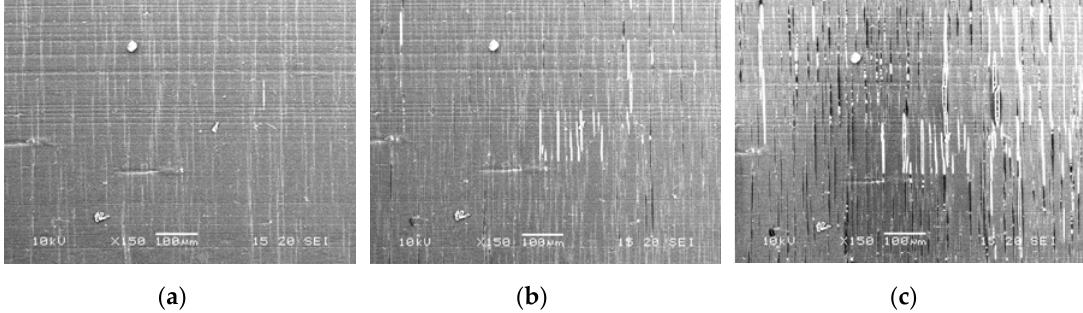
Figure 7. In situ observation of craze formation in the PLA/PHA composite originated by crack nano-bridge toughening via PHA fibers. Uniaxial deformation inside SEM microscope. The respective deformations are ( a ) 0.091, ( b ) 0.140, and ( c ) 0.182.